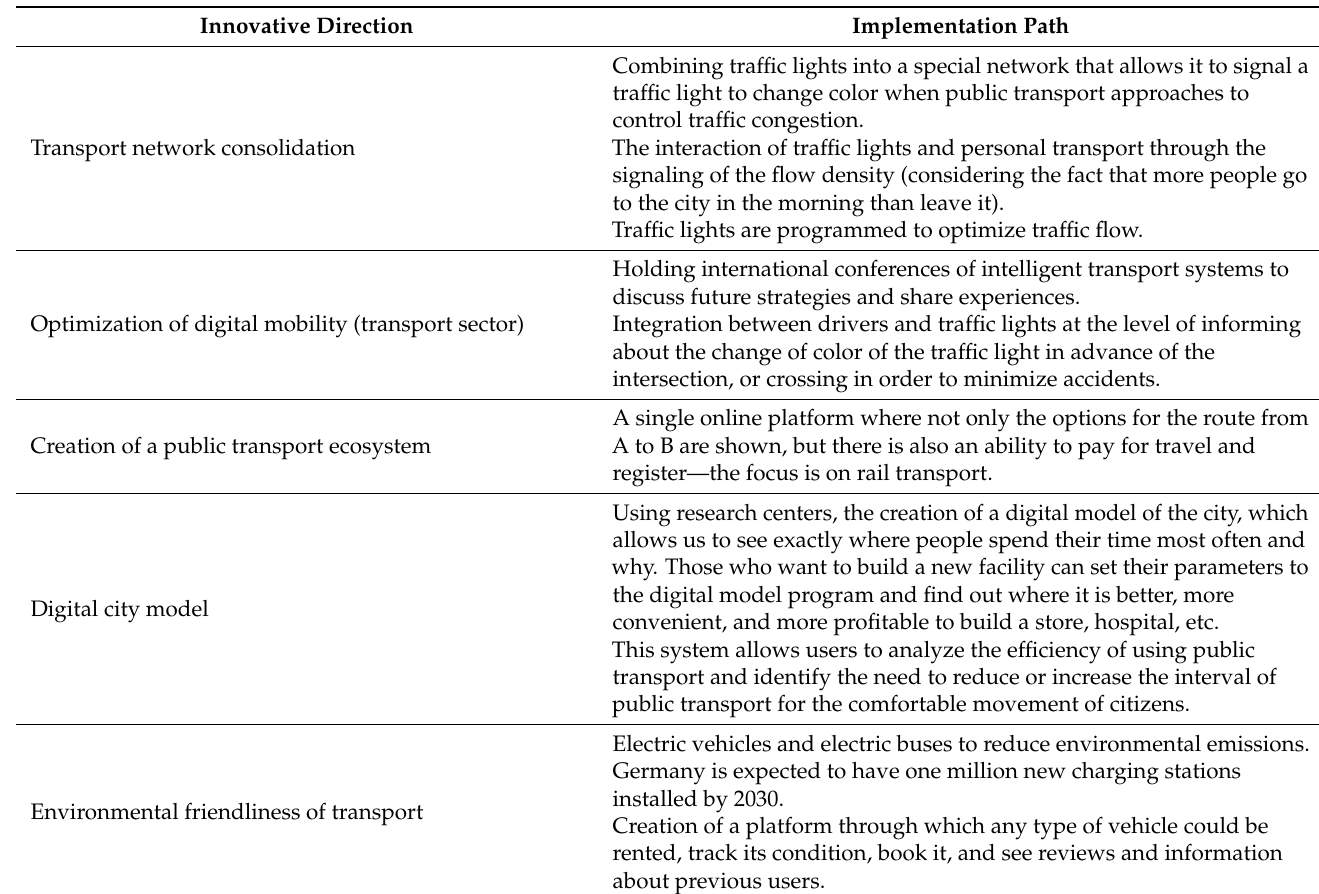
Table A2. Projects for the implementation of smart city in the transport industry in